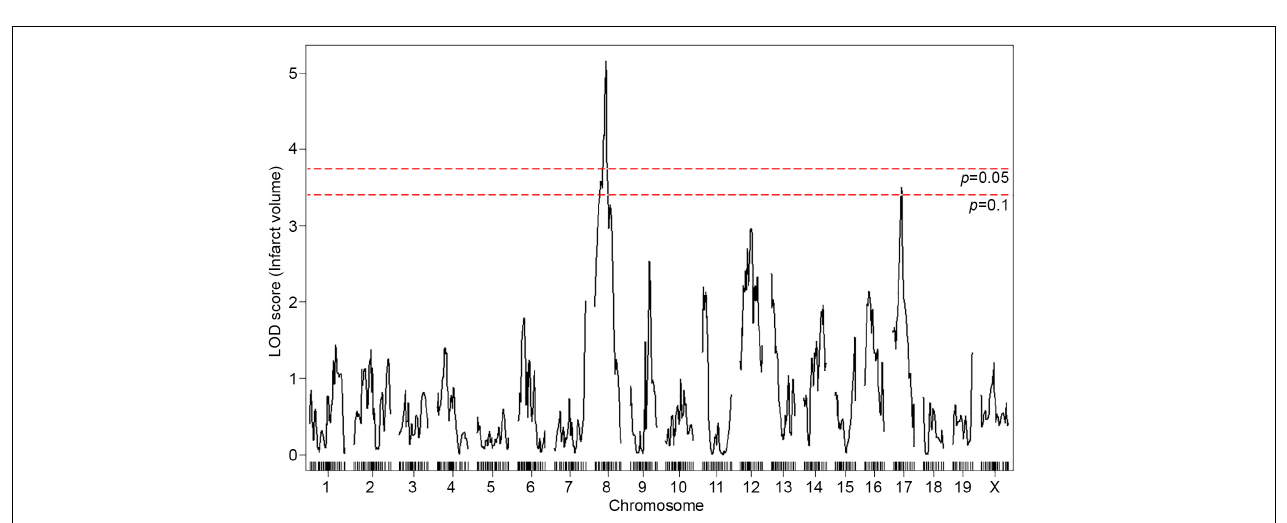
FIGURE 1 | F2 progeny between B6 and WSB display a wide distribution of infarct volume after pMCAO. (A) The scatter plot indicates the number of collateral vessel connections between the ACA and MCA for parental strains, B6 and WSB, and their F1 and F2 intercross animals. The box plot shows the degree of dispersion and skewness. The number of animals for B6, WSB, F1, and F2 was 37, 13, 21, and 30 animals, respectively. (B) The scatter and box plot graphs show the distribution of infarct volume after pMCAO for B6, WSB, and their F1 and F2 intercross animals. The number of animals for the infarct volume measurements was 34, 18, 27, and 376 animals, respectively.